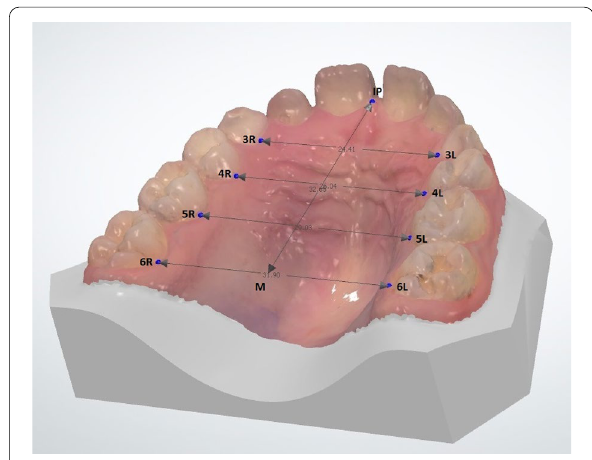
Fig. 4 The view of all measurements on a 3D digital model in different side